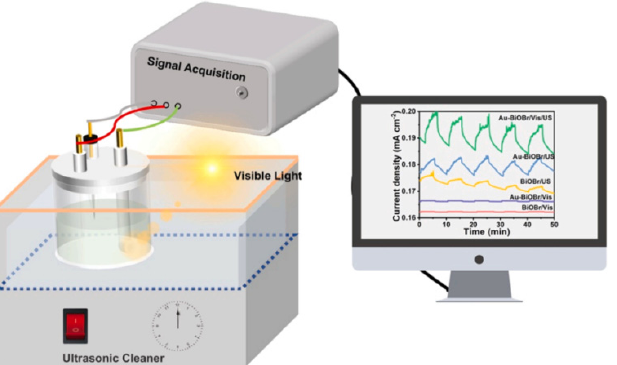
Figure 15. Schematic of the piezo-photocatalytic reactor setup (Reprinted/adapted with permission from Ref. [179]. Copyright 2022, copyright Elsevier).